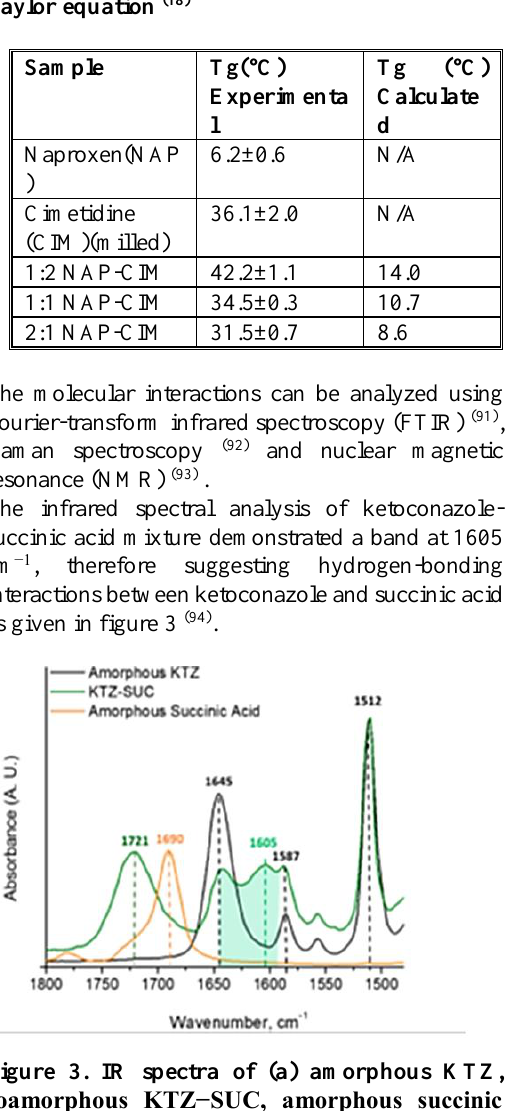
Table 1. Glass transition temperatures of mixtures and single components determined by DSC and calculated values using the Gordon–